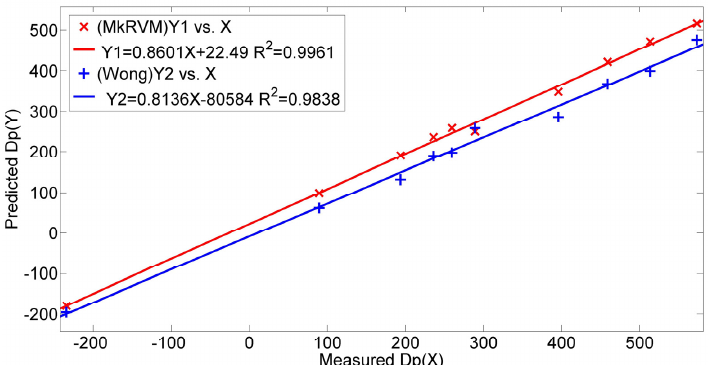
Figure 18. The comparison of correlation coefficient between measured Dp and predicted Dp from the MkRVM and Wong’s